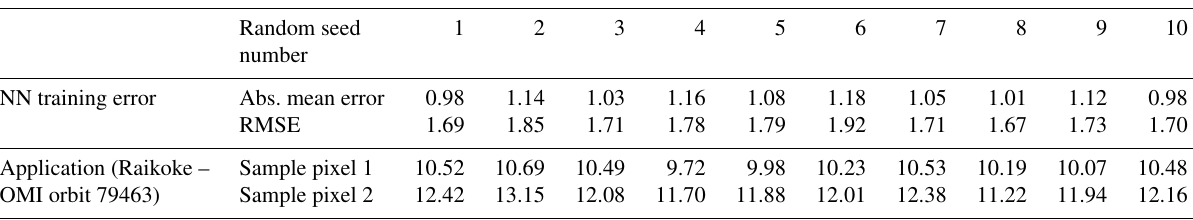
Table A2. Effect of altering random seed number on error obtained using the test dataset and the SO 2 height retrieval result after application to OMI. For the results, heights for two different pixels within the orbit from the Raikoke event (24 June 2019) are shown. Heights were retrieved using separate inverse models trained using 10 random states.